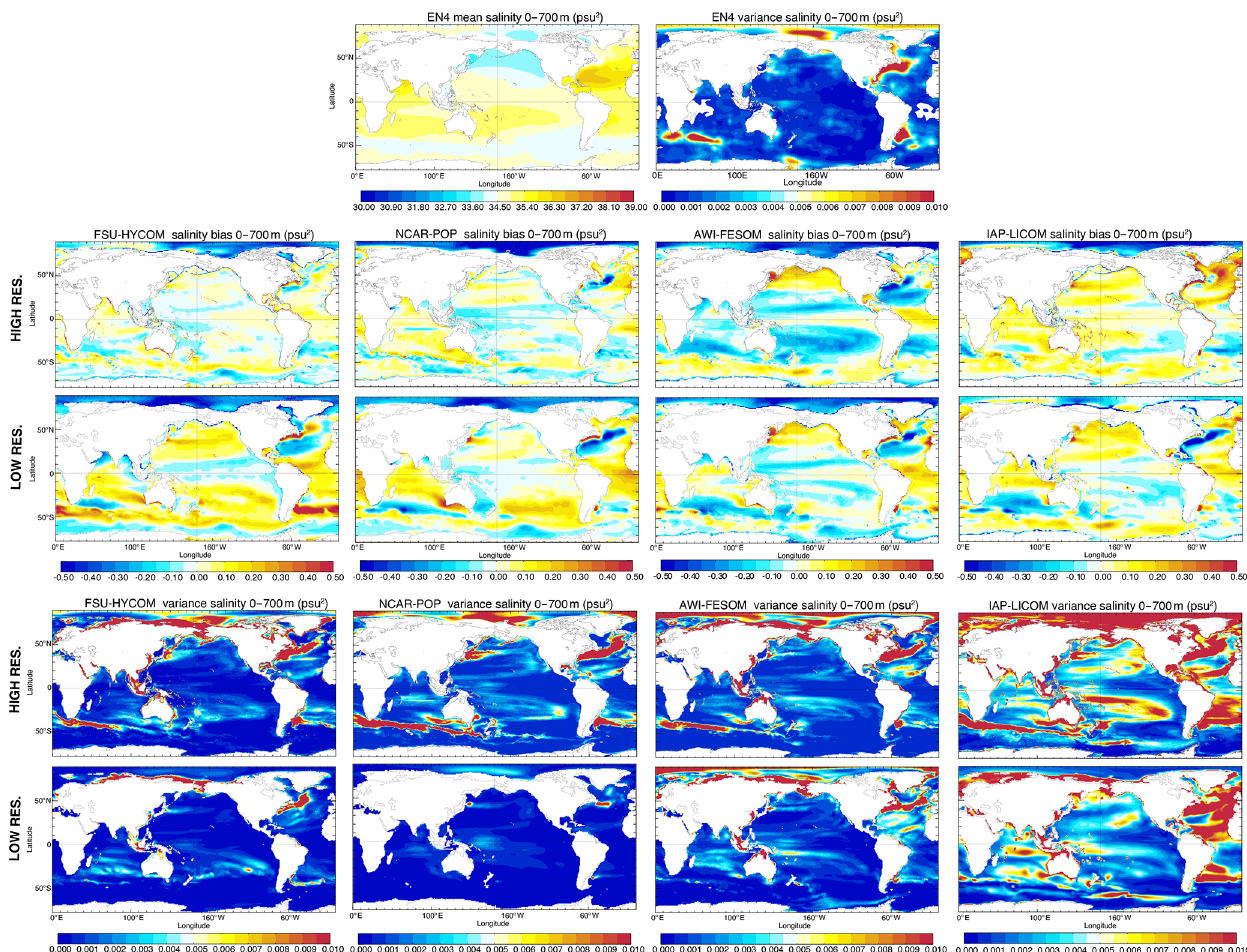
Figure 25. Top panels: mean 1980–2018 0–700m salinity and variance from EN4. Middle panels: difference between the mean modeled 1980–2018 0–700m salinity and EN4. Bottom panels: deseasonalized 0–700m salinity modeled